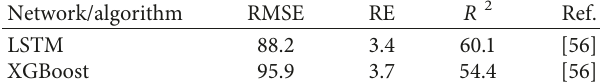
Table 8: The difference in performance of LSTM and XGBoost.